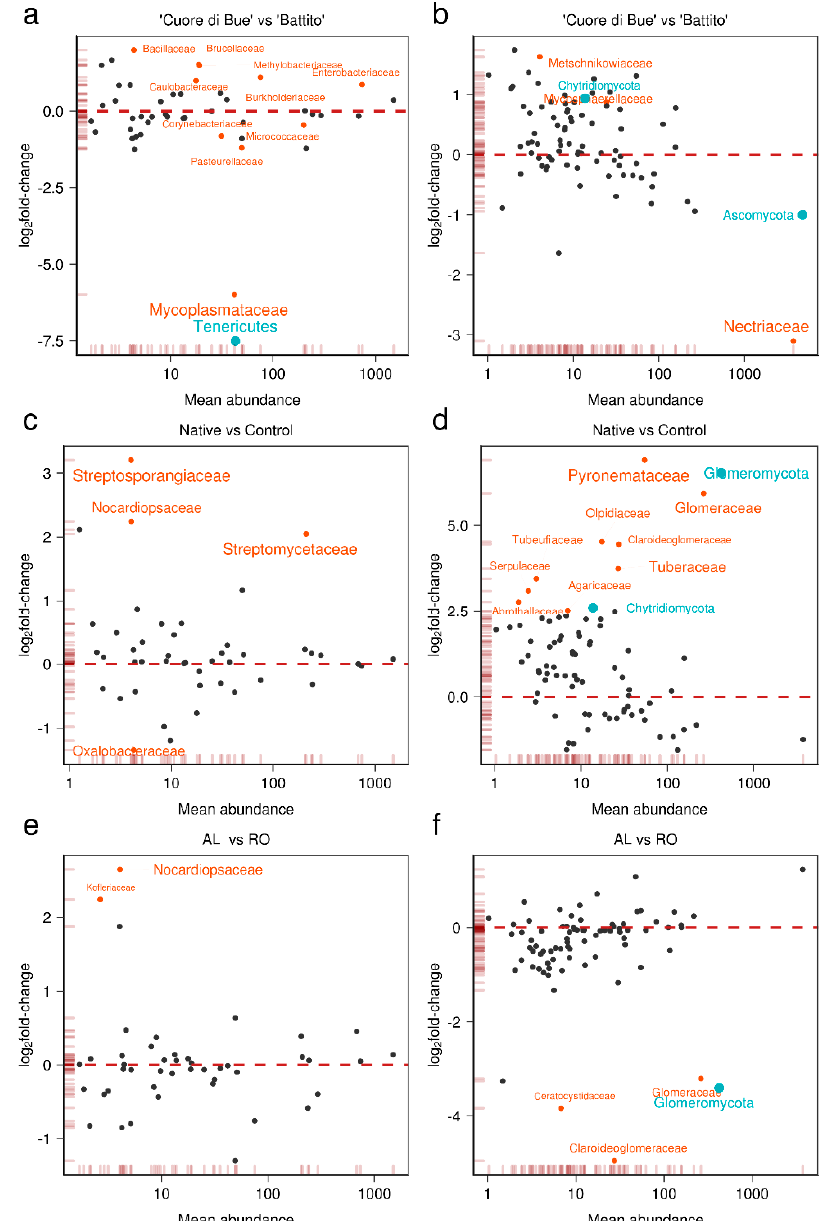
Figure 2. MA-plots of di ff erential abundance analysis of bacterial and fungal families / phyla across genotype and soil types. ( a , b ) Enriched and depleted taxa of bacteria ( a ) and fungi ( b ) associated with “Cuore di Bue” versus “Battito” cultivars. ( c , d ) Enriched and depleted families of bacteria ( c ) and fungi ( d ) in native versus control soil. ( e , f ) Enriched and depleted families of bacteria ( e ) and fungi ( f ) in disease suppressive versus conducive soils. Di ff erentially expressed (False Discovery Rate [FDR] < 0.05) families and phyla are depicted in pale red and light blue, respectively. Taxa name sizes are log 10 -proportional to the adjusted p -value (FDR). Rug density plots (pale red) along each axis indicate the density of abundances ( x -axis) and log 2 fold-changes ( y -axis); x -axis is log 10 -scaled.